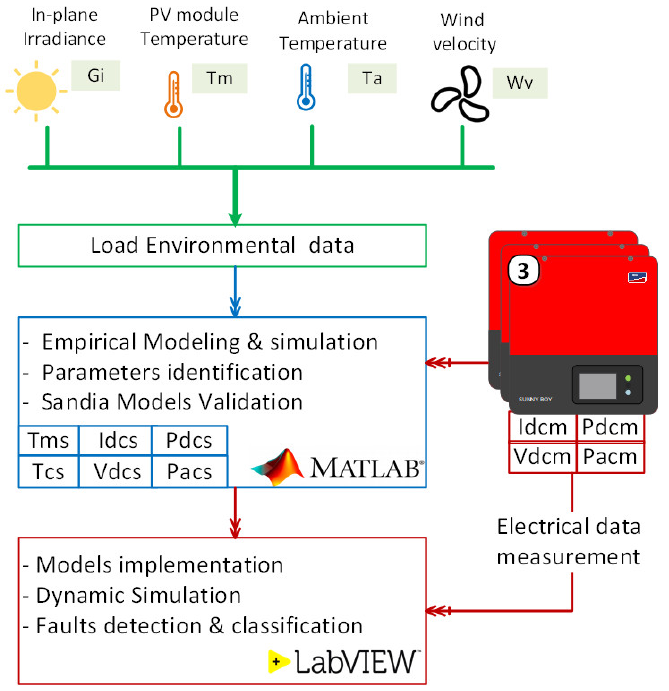
Figure 1. Modeling and fault diagnosis process using MATLAB and LabVIEW.